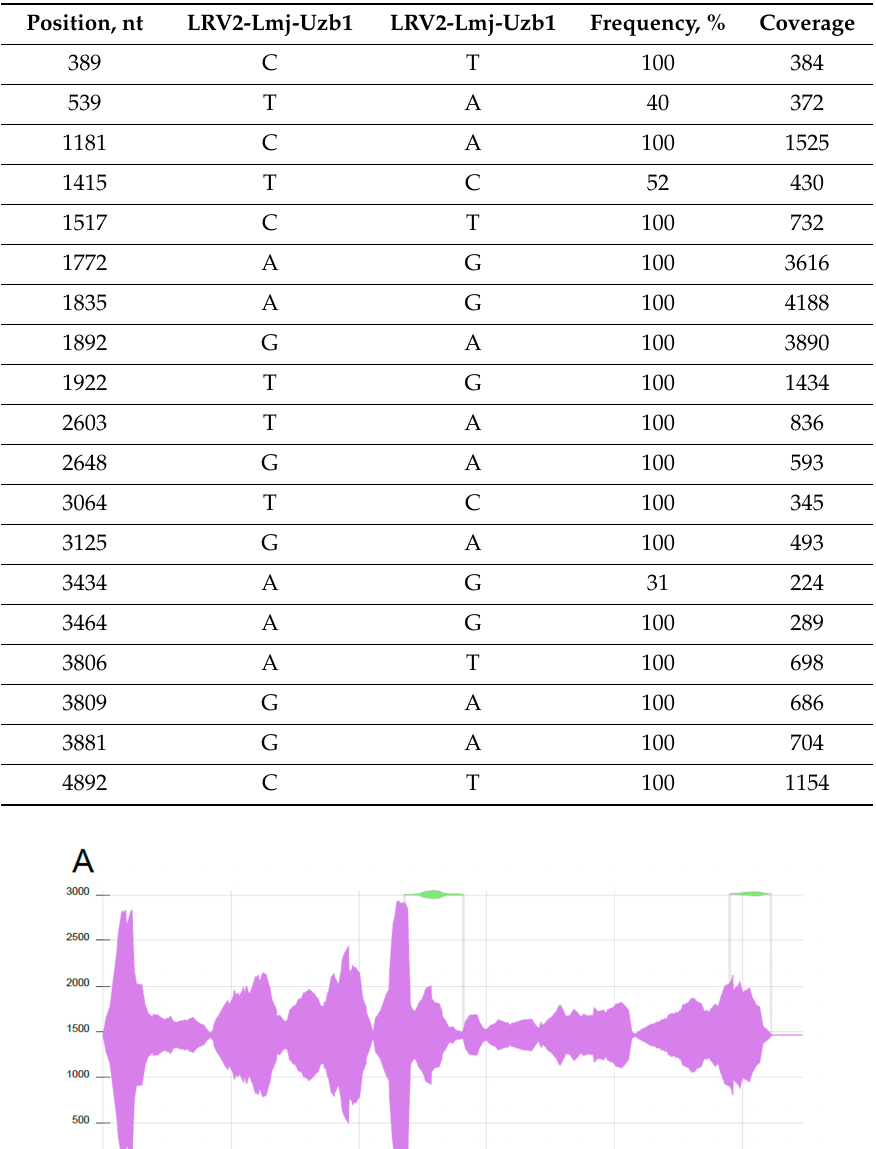
Table 2. SNP comparison between LRV2-Lmj-Uzb1 and LRV2-Lmj-Uzb2. Coverage indicates a total number of sequence reads covering each position on the genome.